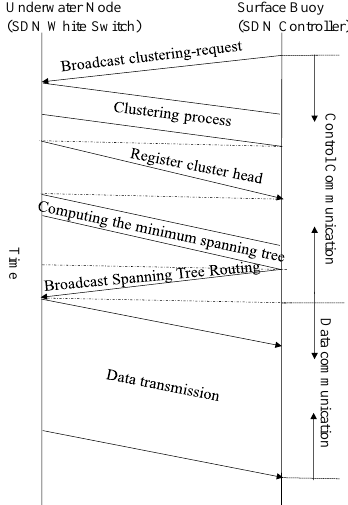
Figure 4. The routing procedure of FL-SDUAN.